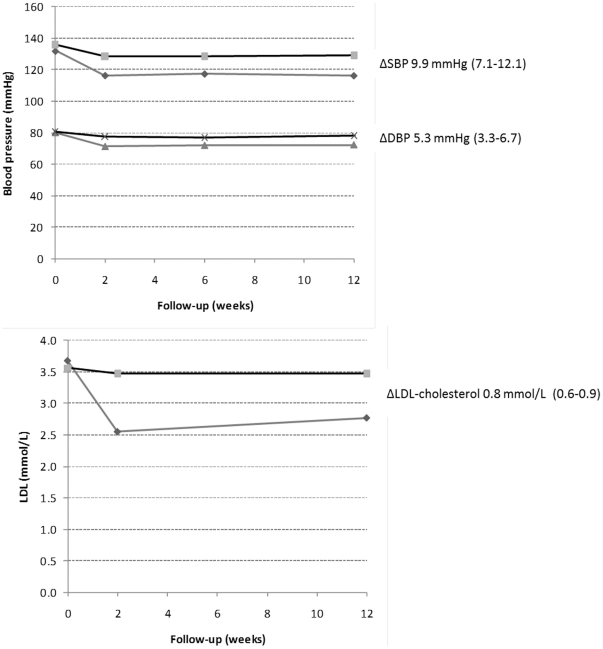
Blood pressure and LDL-cholesterol changes.This figure shows the changes in blood pressure and LDL-cholesterol over
the 12 week trial period, according to active (dark line) or placebo
(grey line).